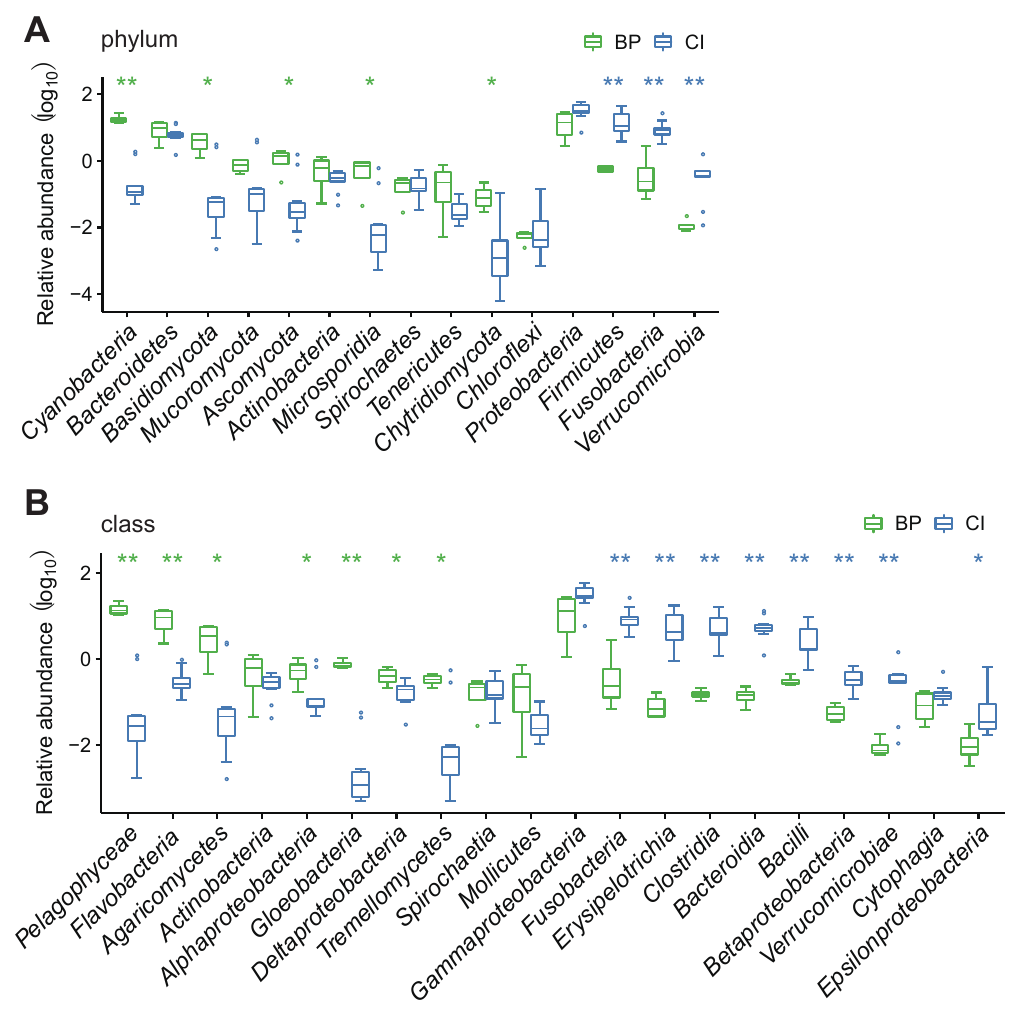
Figure 4. Top abundant microbiota at the phylum ( A ) and class ( B ) levels in herbivorous blue-spotted mudskipper (BP) and their composition in comparison with grass carp (CI). Significance: * 0.01 < p < 0.05, ** p <